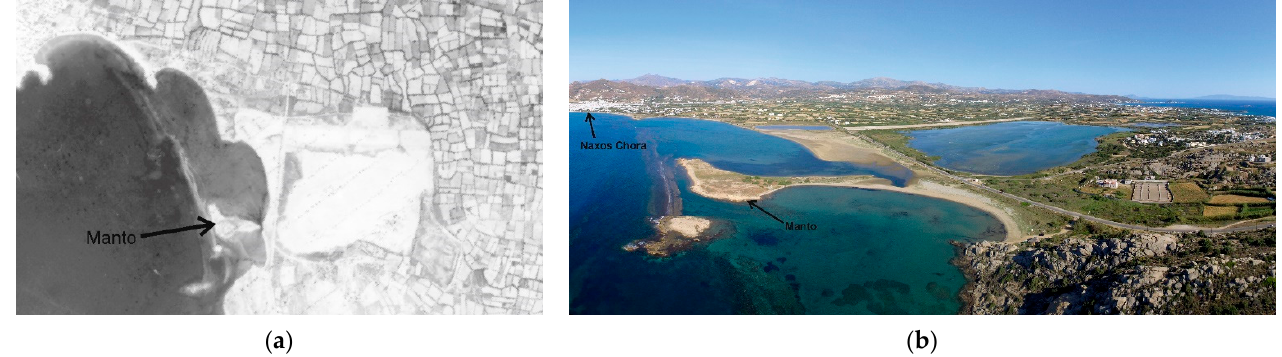
Figure 4. ( a ) Aerial photograph of 1988; ( b ) Drone image from 2019 of the present-day tombolo.